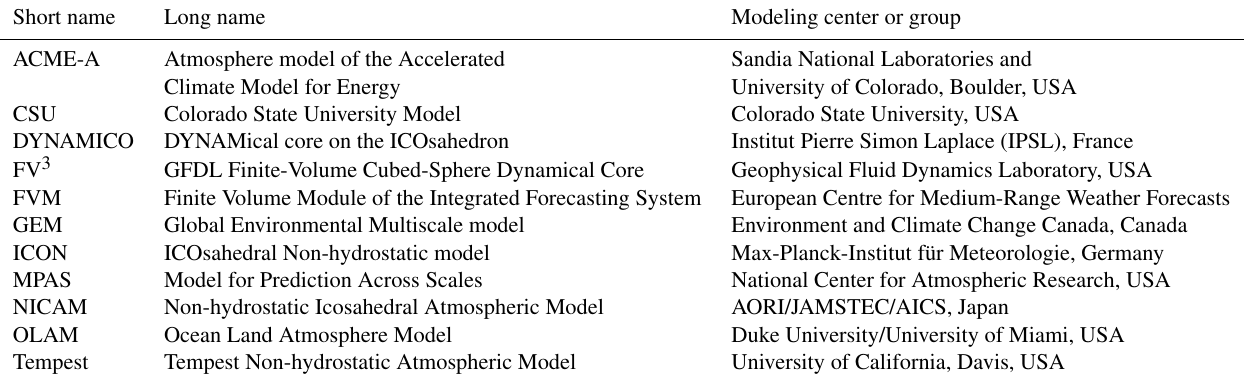
Table 2. Participating modeling centers and associated dynamical cores that have submitted a model description and/or simulation results.